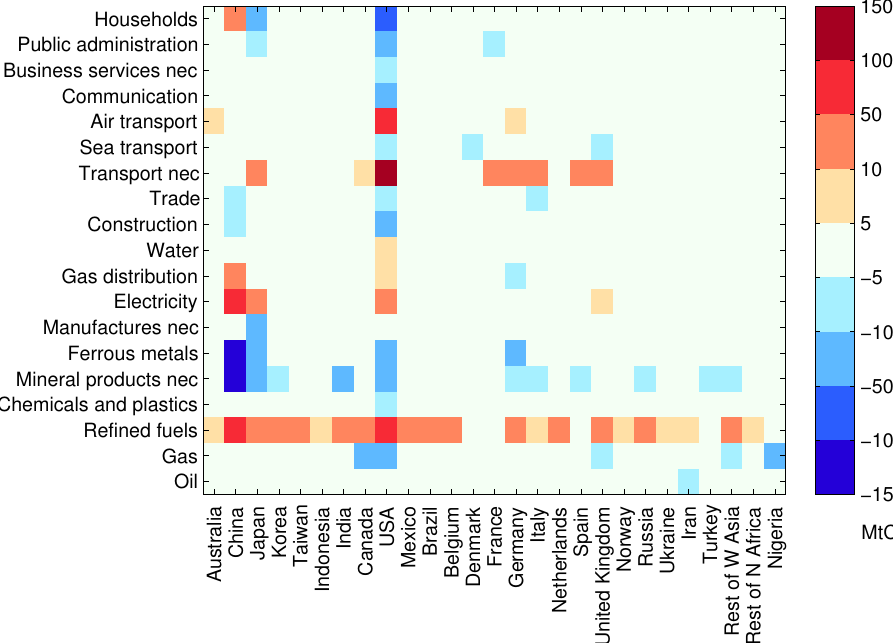
Fig. 2. The difference between the default GTAP CO 2 emission dataset and a version which includes (1) national statistics when available (Australia, NZ, China, Japan, USA, Canada, EU27), (2) cement and flaring emissions, and (3) adjustments to feedstocks used in the refinery sector. The differences are shown by sector and region and are inMtC for 2004. Positive values indicate that “GTAP” is larger. We only show the sector and region combinations where the difference is greater than 5MtC.